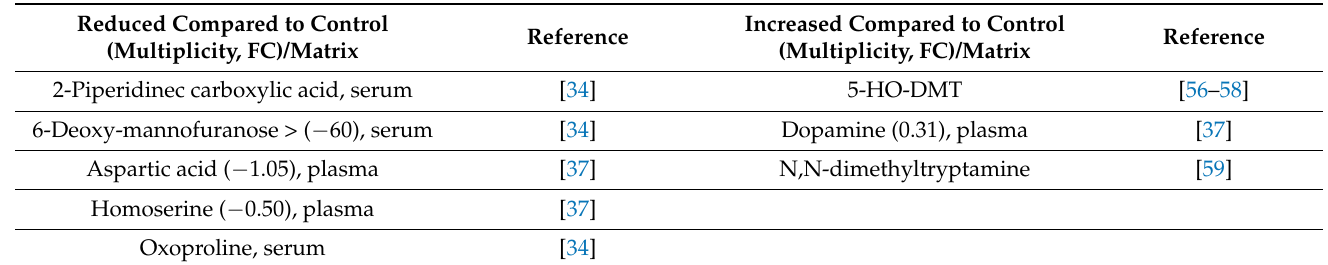
Table 5. Differentiating between schizophrenic patients and healthy controls neurotransmitters and their